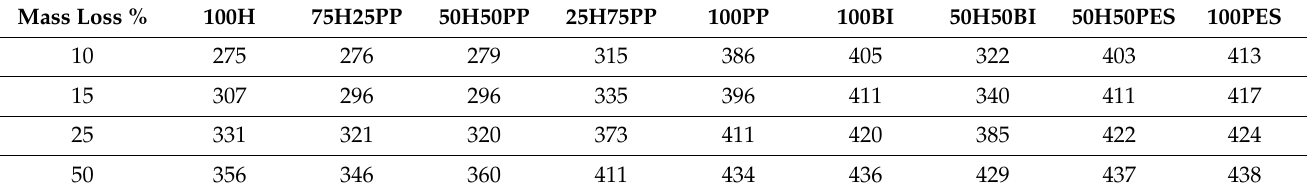
Table 4. Degradation temperature ( ◦ C) and mass loss (%) of hemp, polymers and